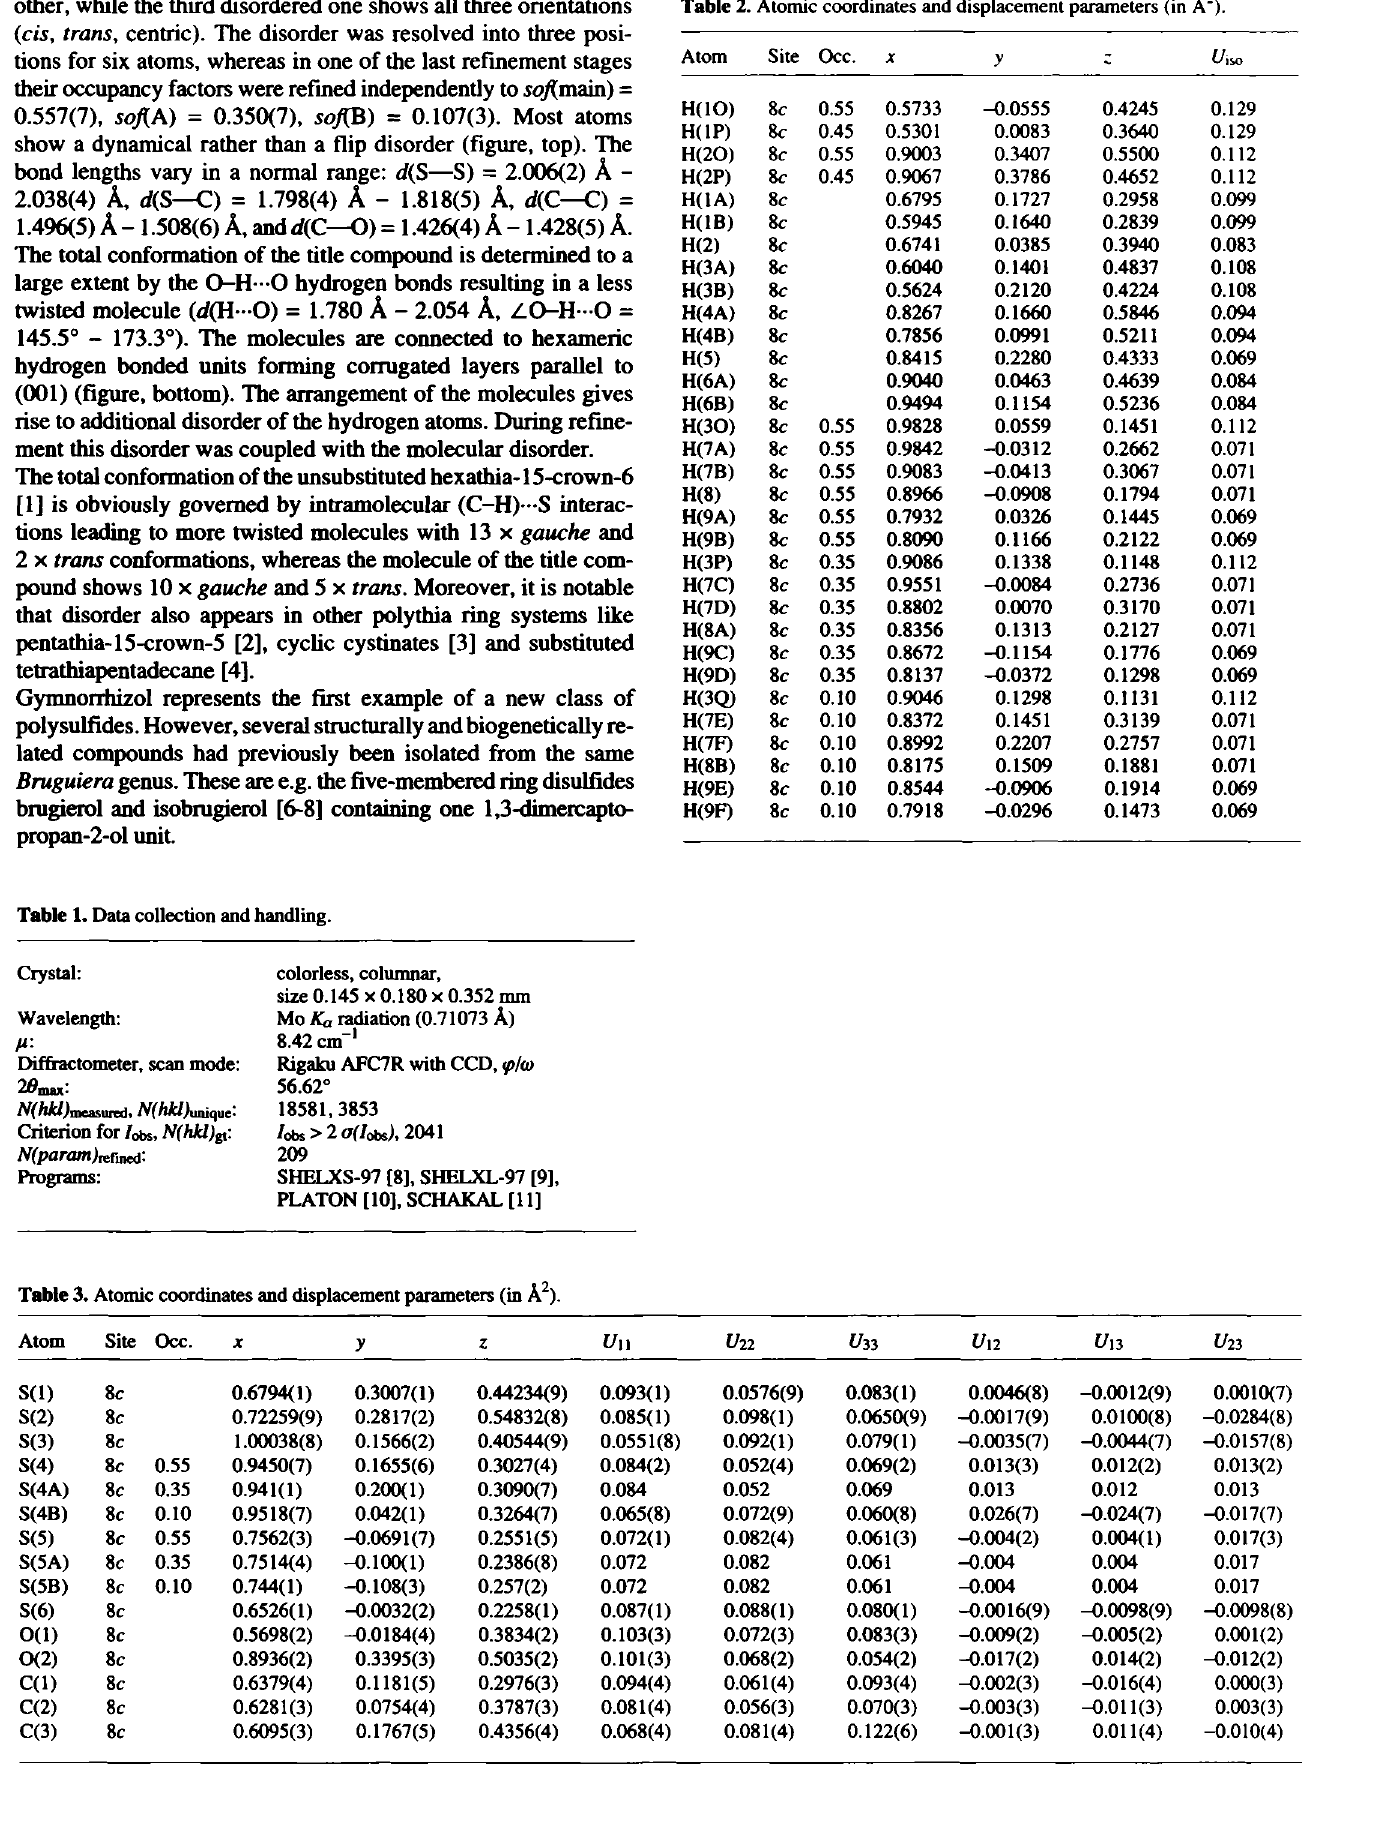
Table 2. Atomic coordinates and displacement parameters (in Â 2 ).